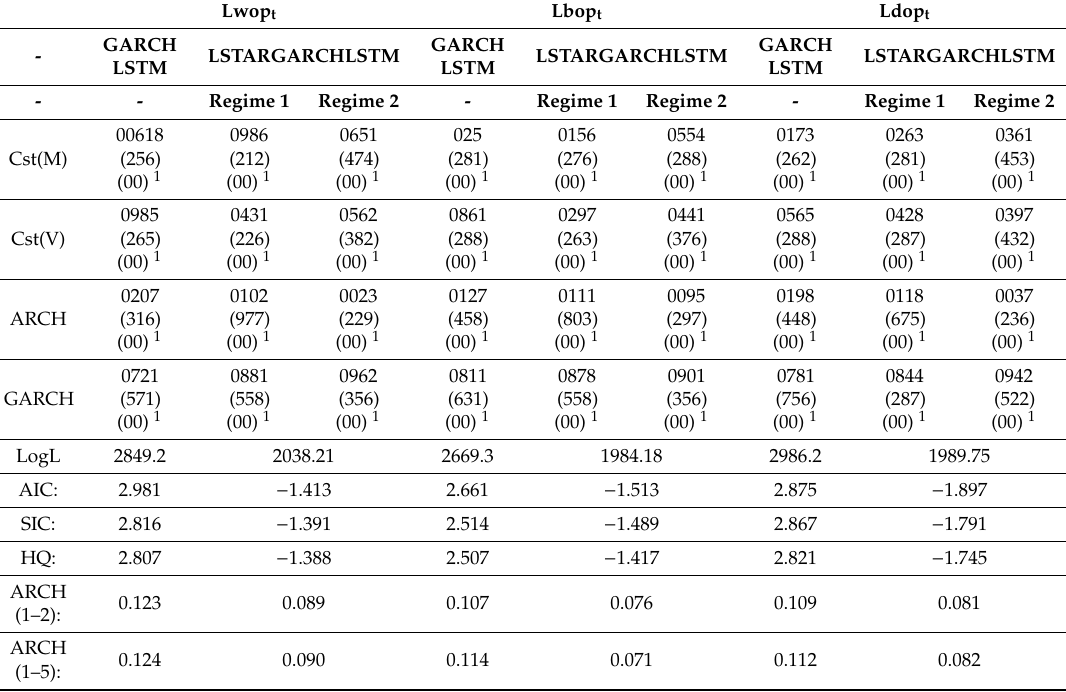
Table 7. GARCHLSTM and LSTARGARCHLSTM. LogL: Log-likelihood, ARCH(p): pth order ARCH–LM test. Lwop t Lbop t Ldop